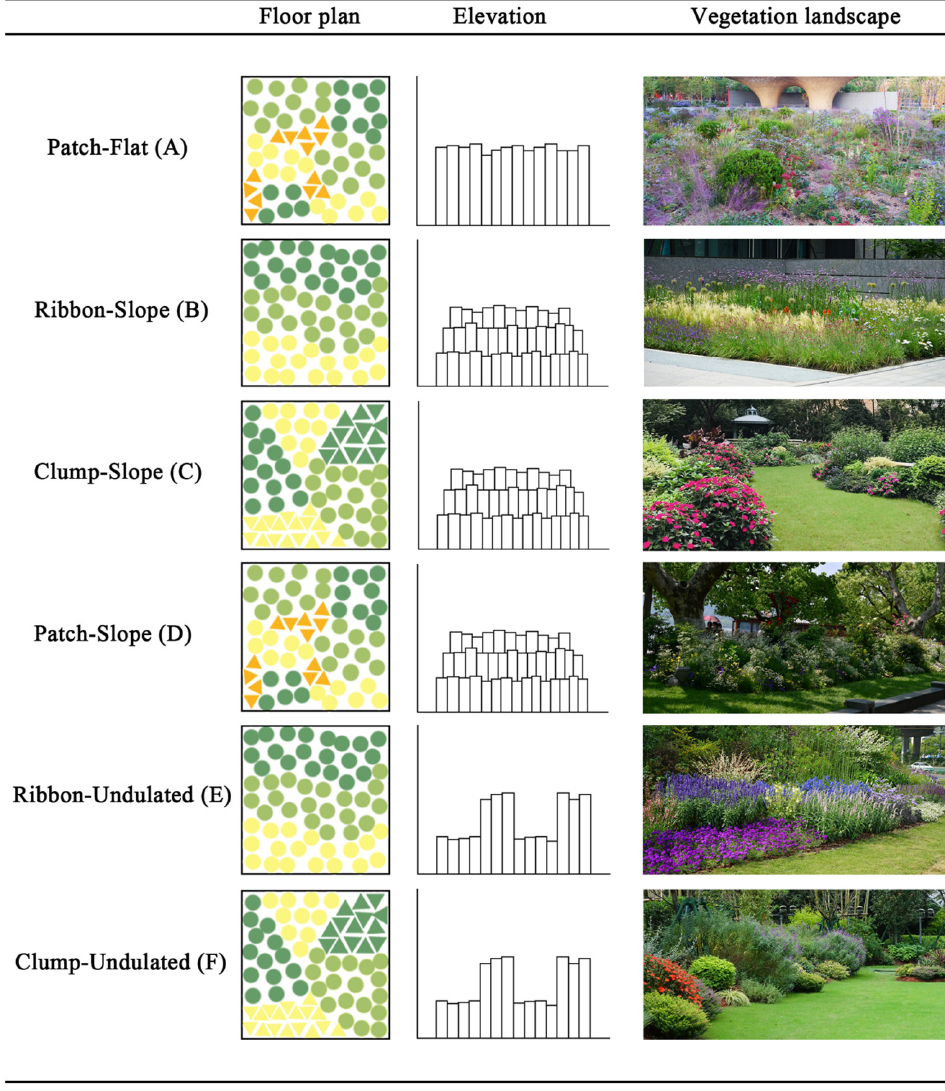
Figure 1. Spatial arrangement patterns for perennials planting landscape. Each legend in “Floor plan” and “Elevation” represents the layout of the plants, but not refer to a certain plant. Table 1. Classification of selected species in terms of plant forms.